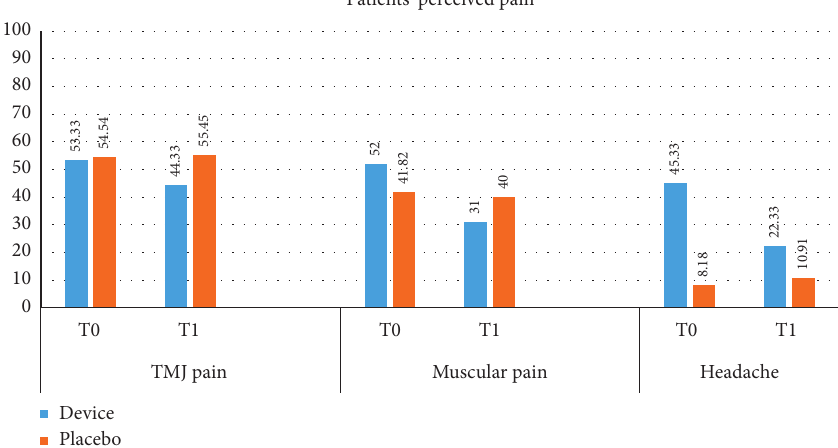
Figure 4: Average values of perceived pain in AG and IG at T0 and T1, according to VAS.